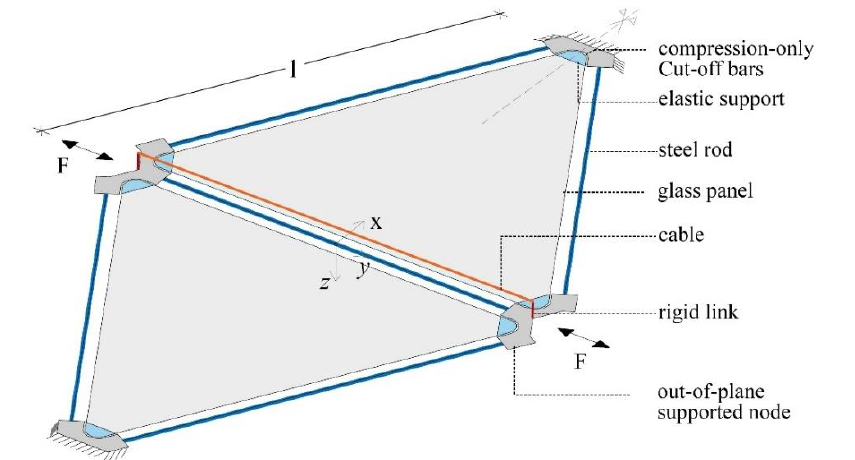
Fig. 11 Static scheme of the elementary unit adopted for the local